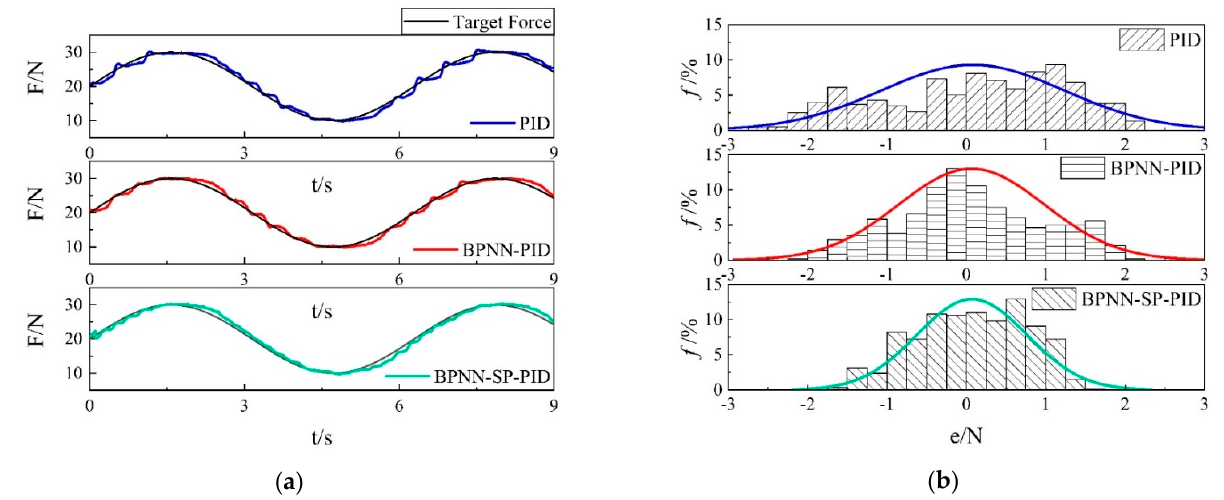
Figure 17. Comparison of actual sinusoid tracking response curves in the experiment. ( a ) Response curves of the three controllers. ( b ) Histogram of the tracking errors.